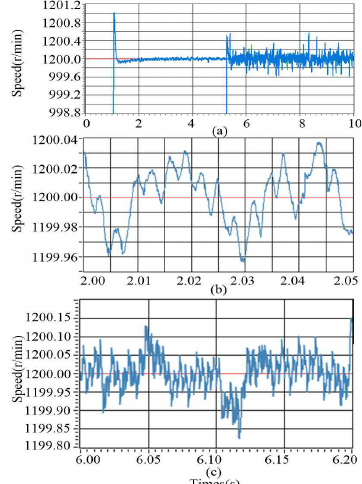
Figure 37. The observed speed using VPDPI at 1200 r/min. ( a ) The overall response diagram of observed speed at 1200 r/min. ( b ) Observed speed under no load. ( c ) Observed speed under 2 N m ·